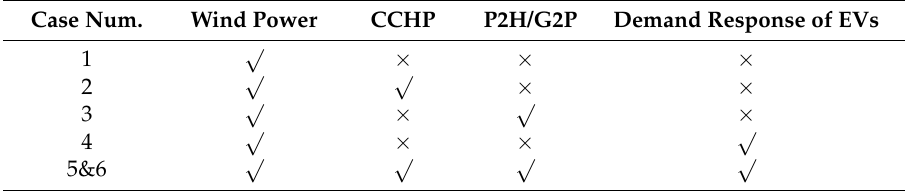
Figure 7. Hourly forecasted wind power and demand distribution. ( a ) Forecasted wind power and electric demand. ( b ) Multi-energy demand. Table 4. Case design.